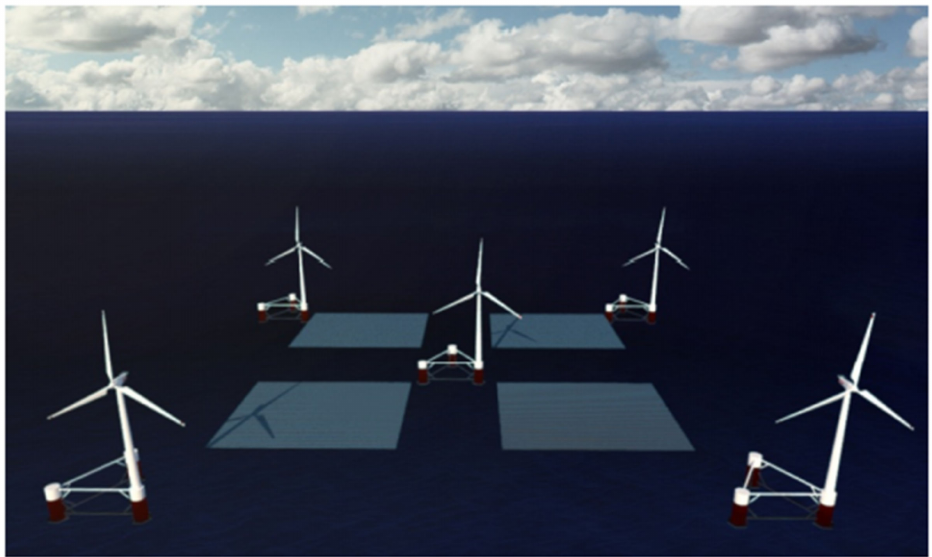
Figure 4. Schematic of combined floating wind and solar energy farm